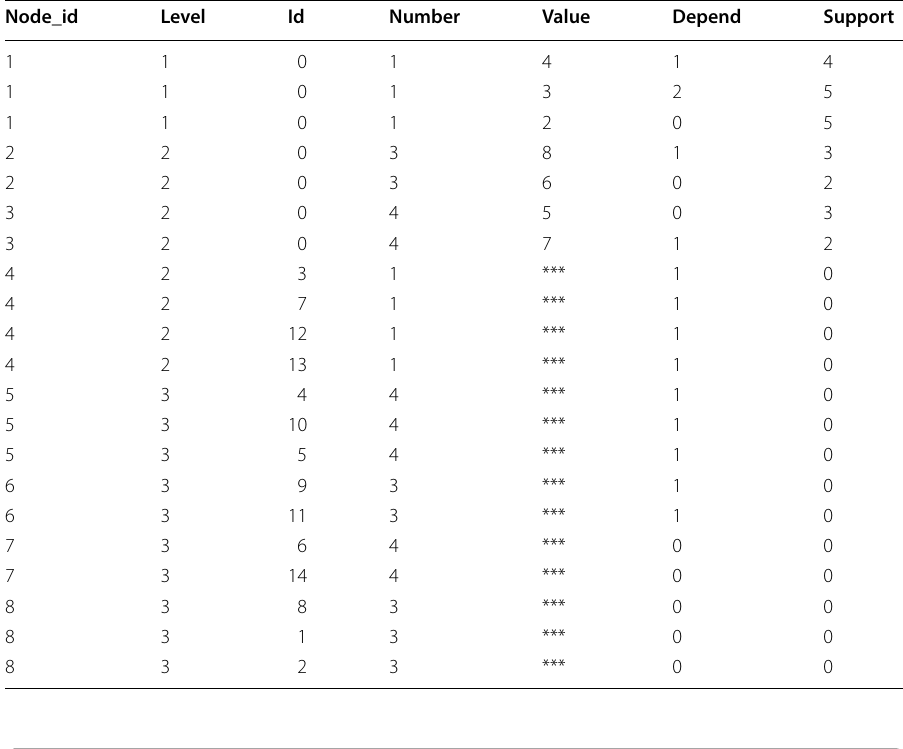
Table 4 Node-instance records of iteration 2’s output